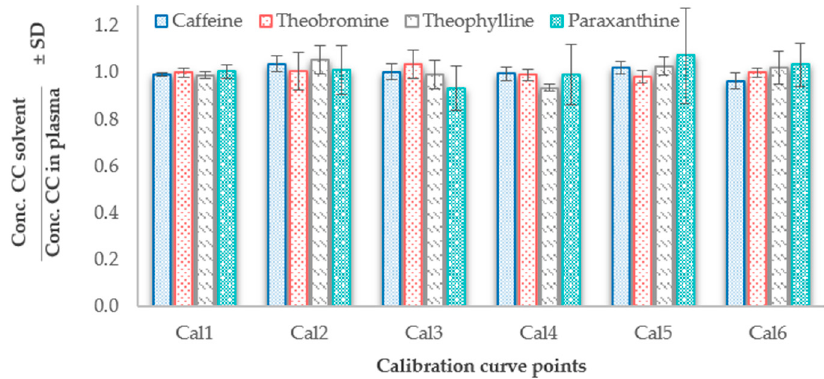
Figure 3. Comparison of the regressed calculated concentrations (conc.) using the calibration curve (CC) prepared in plasma compared to the calibration curve prepared in solvent. The bars represent each one the six calibrators showing the ratios of the calculated concentrations using the solvent regression model against the plasma regression model. For each calibrator point (bar), the mean ± SD was calculated using data acquired from five non-consecutive days ( n = 5).